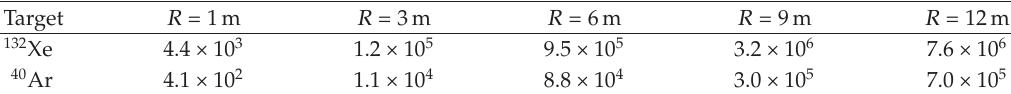
Table 6: Number of events in a year for a spherical detector of various radii R with its center at a distance L (cid:8) 50m from the source. The vessel is filled with gas under pressure P (cid:8) 10Atm and temperature T 0 (cid:8) 300K. The total cross sections are obtained summing over all neutrino flavors. The chemical potential of the neutrino spectra is taken as α (cid:8) 0.